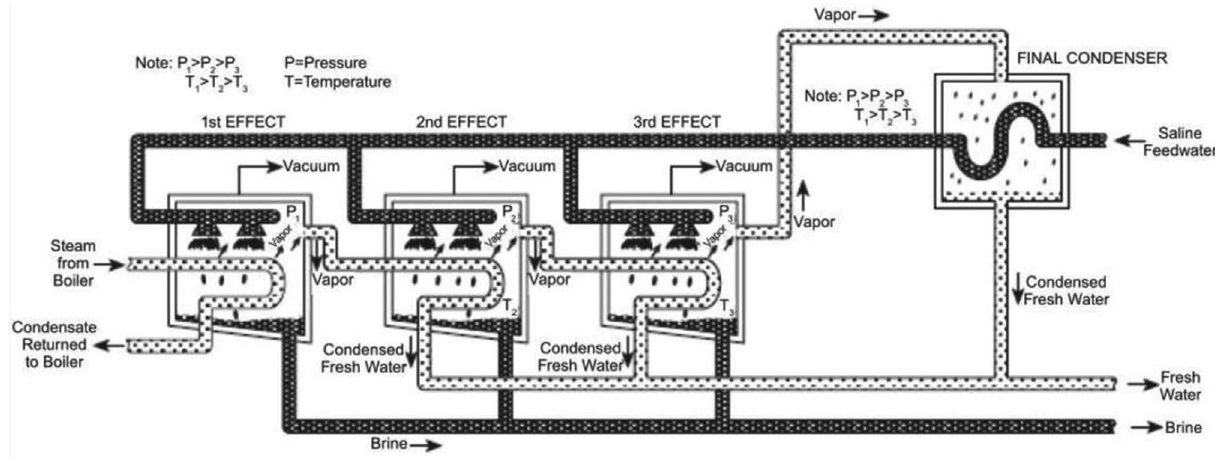
Fig. 15 The multi-effect distillation process for recovering saline feedwater (El-Ghonemy